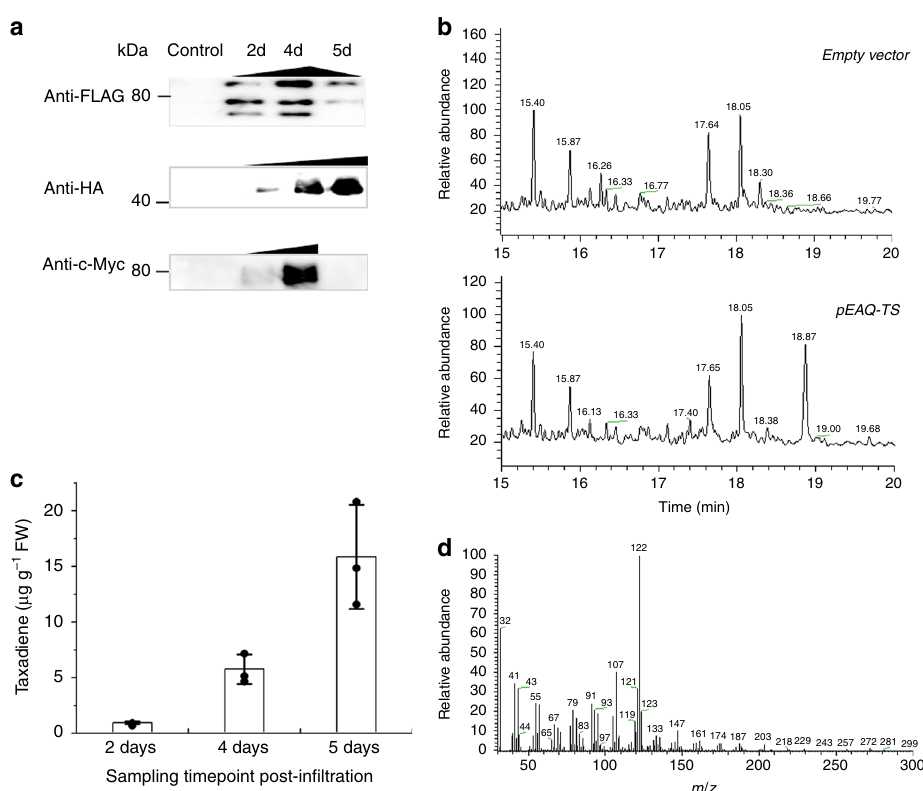
Fig. 2 Expression of Taxus-originated proteins and committed taxadiene production in N. benthamiana . a Accumulation of TS, T5aH and CPR in plants by immunoblot analysis after agroin fi ltration. Leaves in fi ltrated with A. tumefaciens cultures harboring the empty vector were set as controls. b GC – MS analysis of hexane extracts from in fi ltrated N. benthamiana leaves at 5 dpi (days post-in fi ltration); upper panel is control and bottom panel is TS-expression leaves. Accumulation of taxadiene (the peak at the retention time 18.8 min) was detected both in TS-expression leaves and TS, T5 α H and CPR co- expressing leaves. No taxadiene-5 α -ol was detected in the TS, T5 α H, and CPR co-expression leaves. c Accumulation of taxadiene in agro-in fi ltrated leaves at 2, 4, and 5 dpi. d Mass spectra pro fi le of the compound at 18.8 min matched exactly with the taxadiene mass spectra. Data in c represent the mean of n = 3 biologically independent samples (closed circles) and error bars show standard deviation. The source data of a , c are provided as a Source Data fi